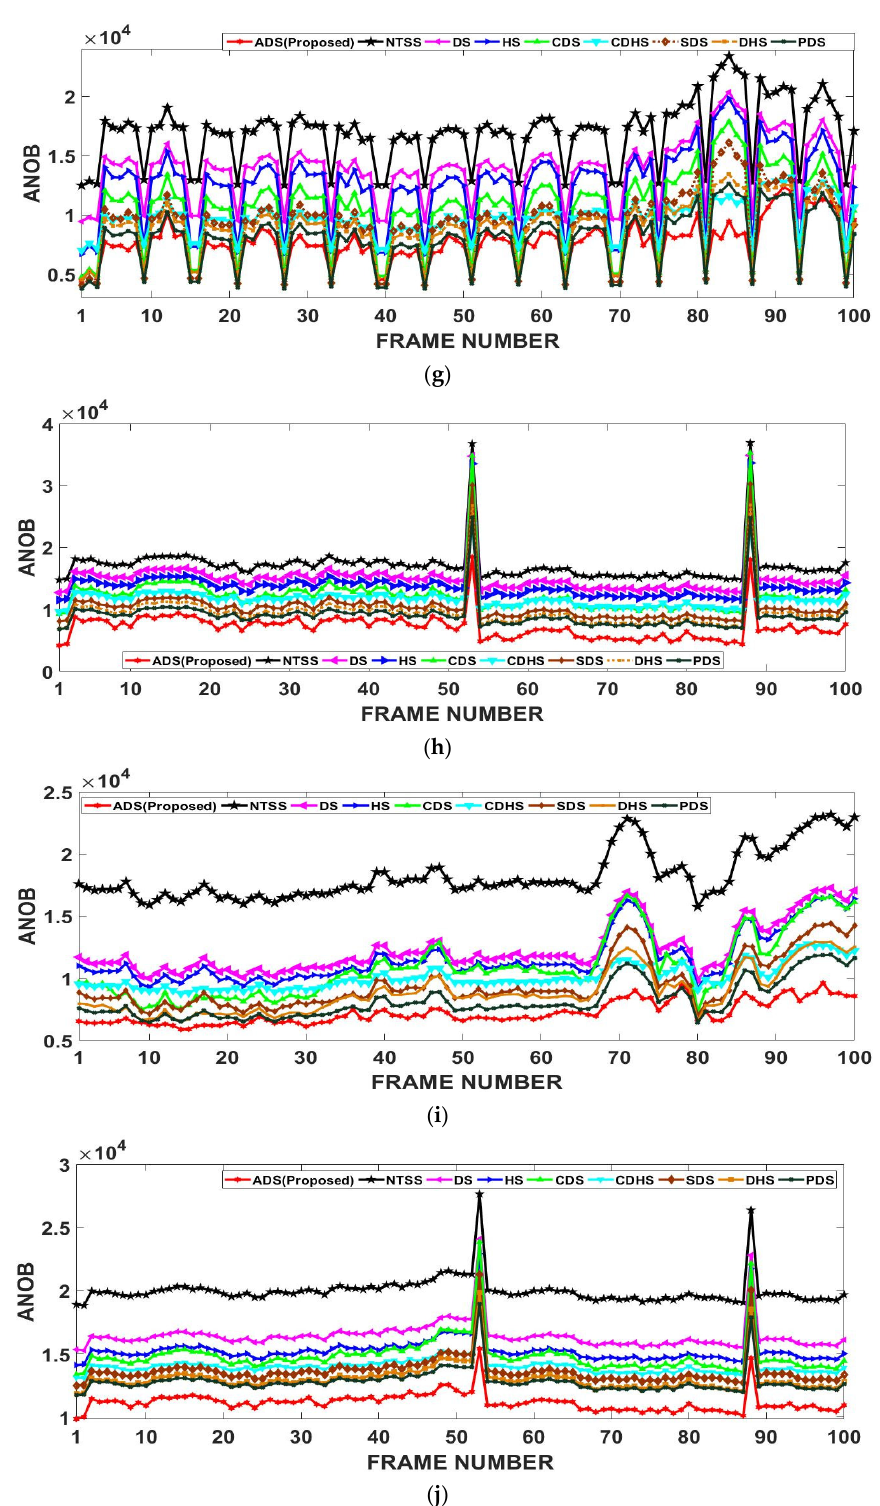
Figure 8. Computational cost comparison of the proposed ADS algorithm and other state-of-the-art and well-known motion estimation algorithms in terms of average number of operations per block (ANOB) for various video sequences: ( a ) Foreman, ( b ) Mobile, ( c ) Rhinos, ( d ) Robot boat, ( e ) Suzie ( f ) Akiyo, ( g ) Cricket, ( h ) Flower, ( i ) Kari-Jobe, and ( j ) News